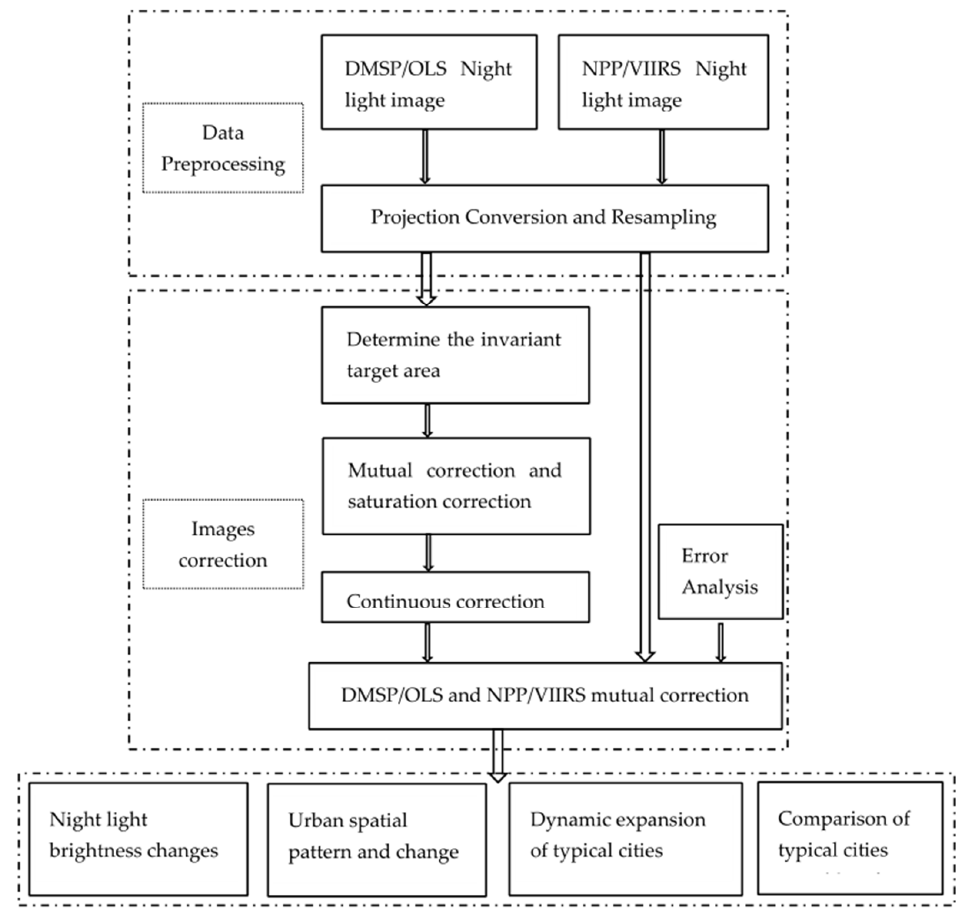
Figure 2. Workflow of data and methods.